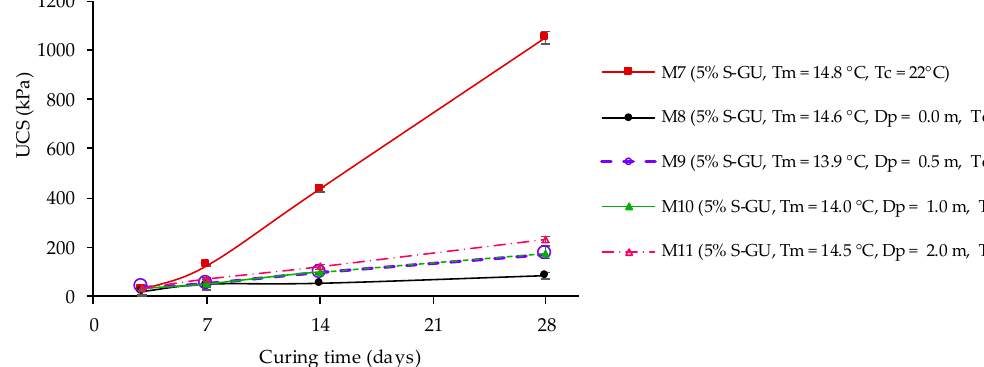
Figure 3. UCS variation with curing time for CPB containing 5% S-GU (blend of 80% Slag and 20% GU) cured at a constant temperature (22 °C) in the humidity chamber (M7) and at decreasing temperatures (M8 to M11) depending on the distance from the CPB–permafrost wall interface: 0 m (M8), 0.5 m (M9), 1 m (M10), and 2 m (M11).